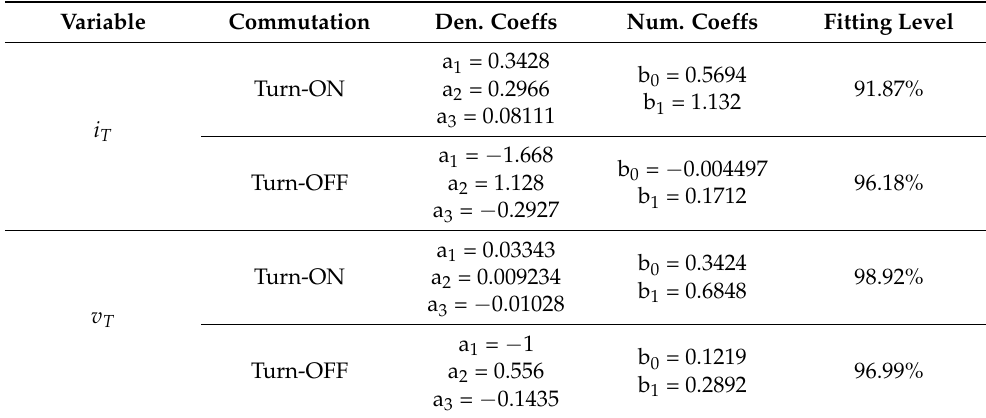
Figure 3. Initial experimental waveforms vs. obtained FPGA-based RT results. Reprinted/adapted with copyright permission from [26]. Table 1. Coefficients of the FTs provided by the system identification